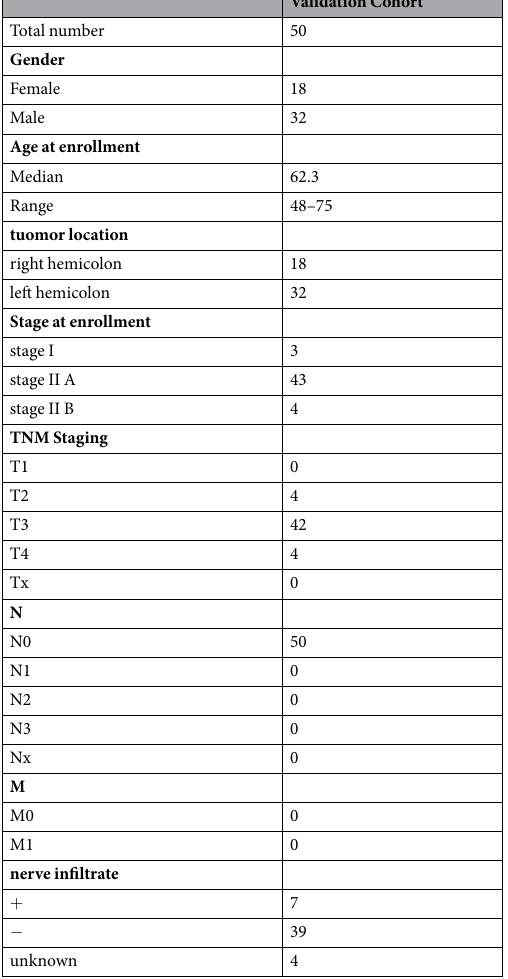
Table 2. Clinical characteristics of early-stage colon cancer patients.